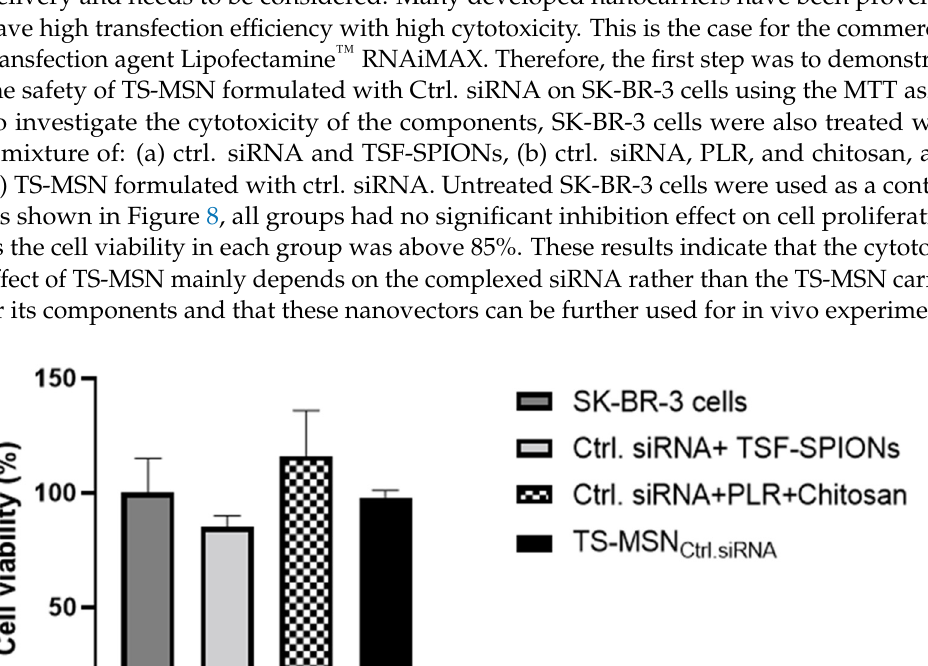
Figure 9. IC 50 values of Doxorubicin on SK-BR-3 cells, determined at different time points: ( A ) 4 h, ( B ) 24 h, ( C ) 48 h, and ( D ) 72 h using the MTT cytotoxicity assay. The last step was to combine the individual delivery of TS-MSN formulated with siSurvivin (TS-MSN siSurvivin ) and DOX in SK-BR-3 cells. The cells were treated with TS-